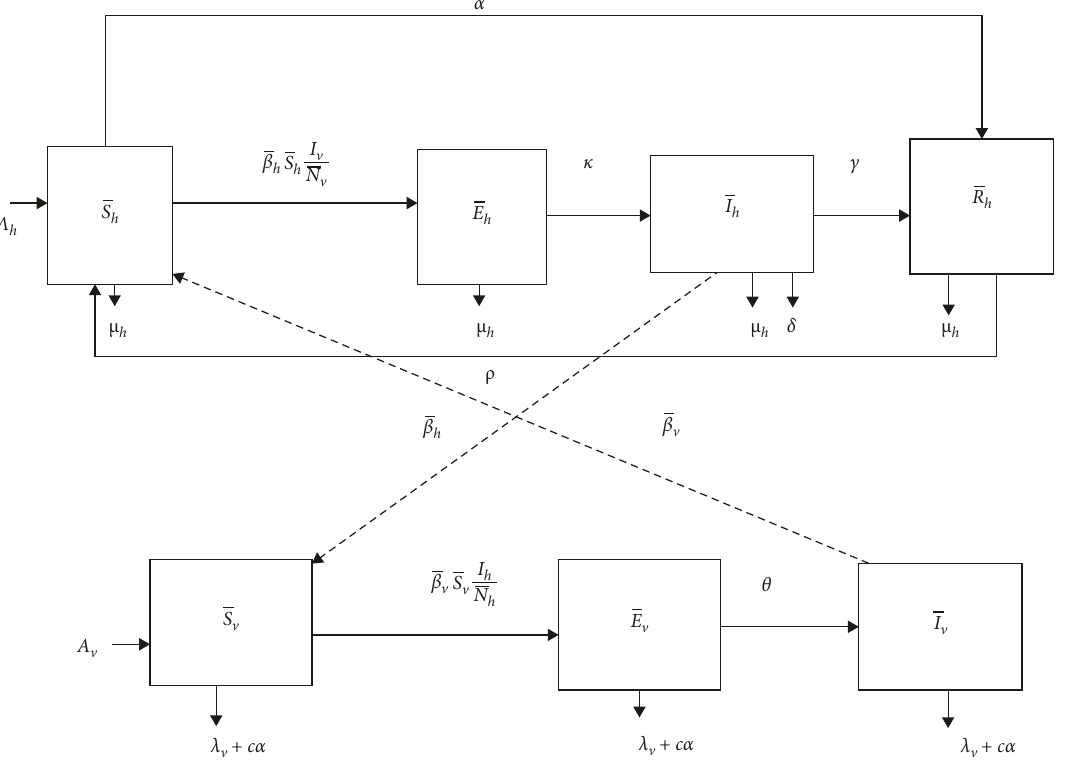
Figure 1: Transition diagram for a malaria transmission model. Table 1: Model parameters and their